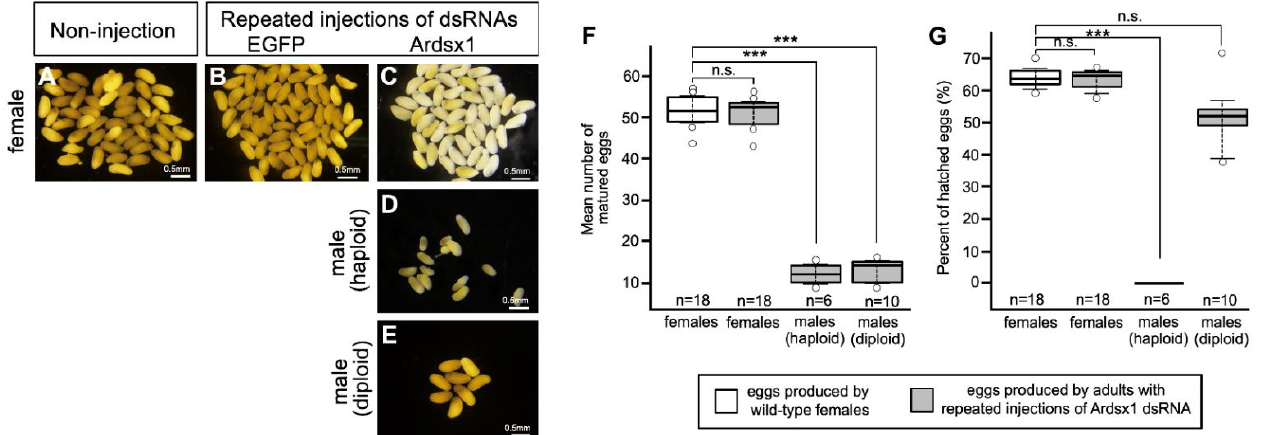
Figure 4. Effects of RNAi-mediated knockdown of Ardsx on oogenesis. Mature eggs obtained from ovaries in wild-type female ( A ), negative control female ( B ), Ardsx -knockdown female ( C ), Ardsx -knockdown haploid male ( D ), and Ardsx - knockdown diploid male ( E ). ( F ) The number of eggs obtained from wild-type females and Ardsx -knockdown haploid and diploid males produced via repeated injections of Ardsx dsRNA. ( G ) Hatchability of parthenogenetically activated eggs produced by wild-type females and Ardsx -knockdown haploid and diploid males produced via repeated injections of Ardsx1 dsRNA. The values shown by each sample and their distributions were represented by box-and-whisker plot. *** Significant difference at the 0.01 level (Mann – Whitney U test) compared with the wild-type females. n.s. means no significant difference between two groups (Mann – Whitney U test).